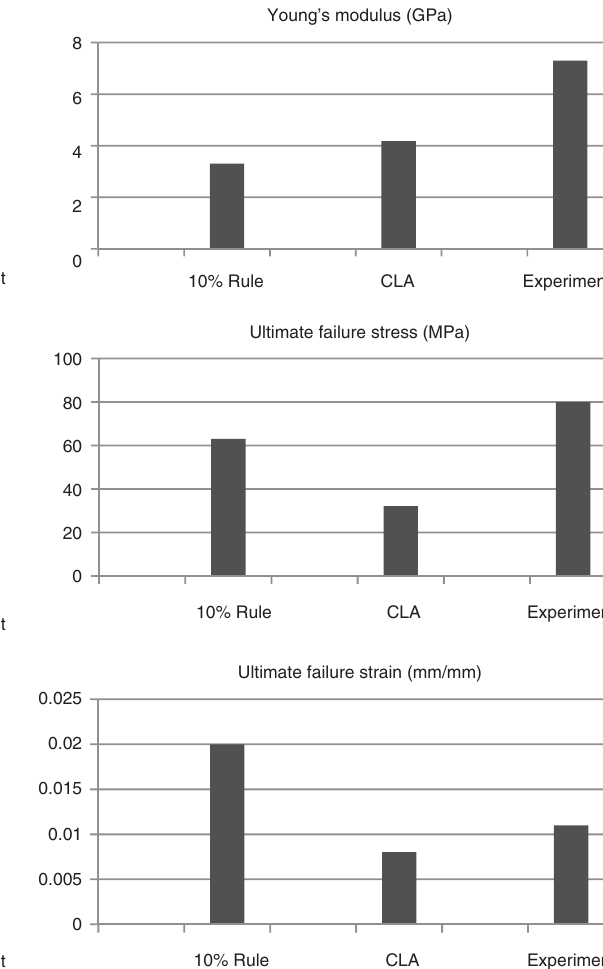
, -90 ] comparison results. Figure 4 Summary of [+67.5 4 4 s